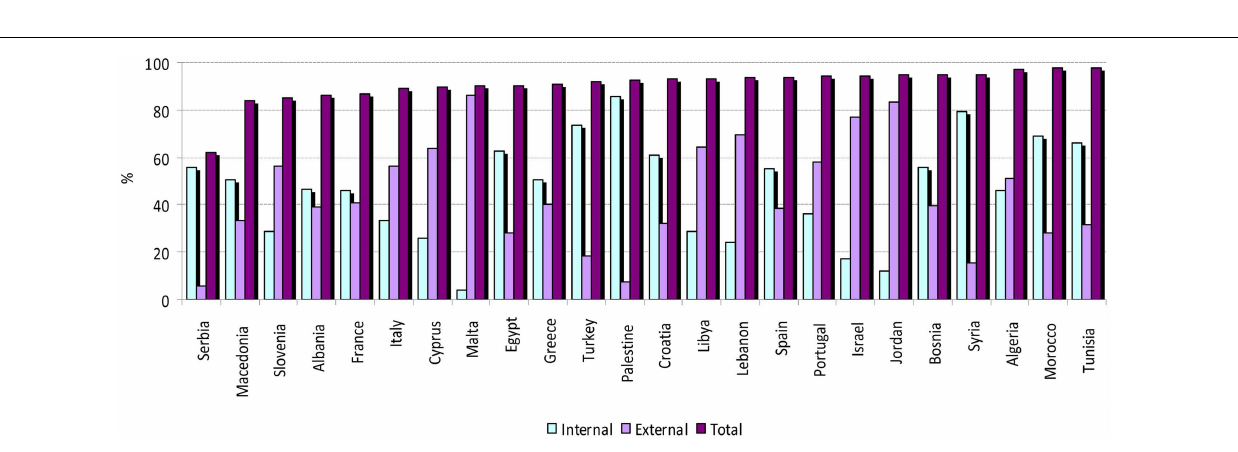
FIGURE 5 |WF of agricultural products consumption in Mediterranean countries [Source: adapted from Ref. (47)]